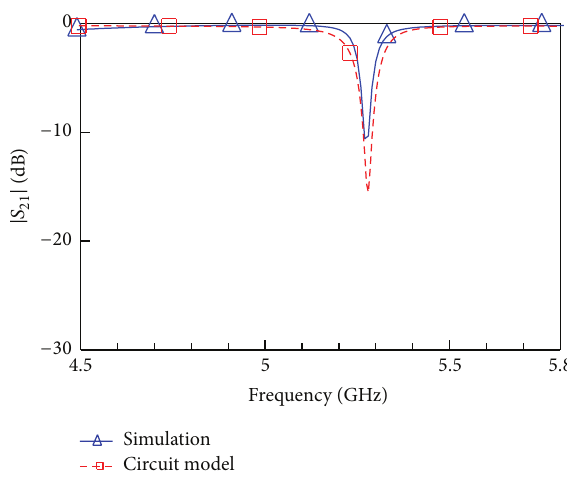
Figure16:Comparisonofcircuitmodelandsimulatedtransmission coefficient results of transmission line loaded with CSRR.